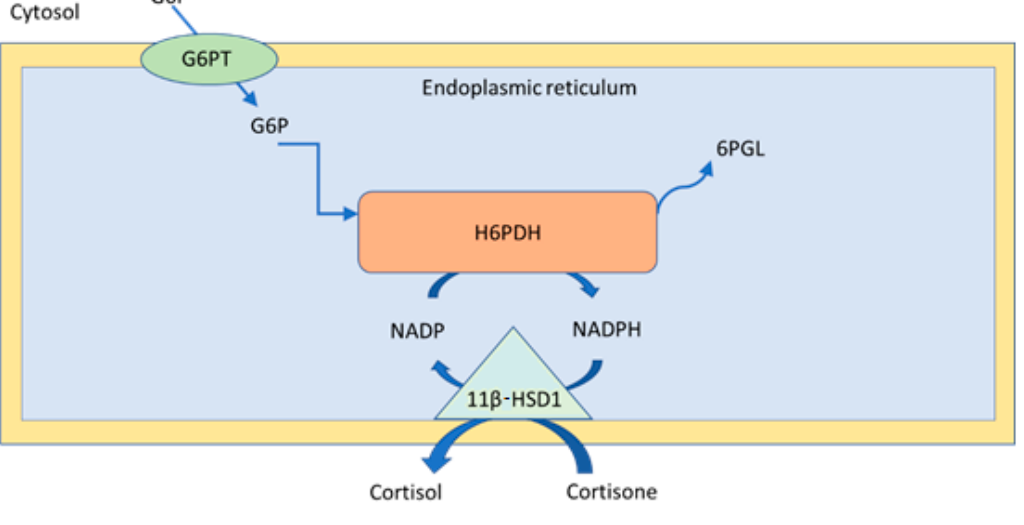
Figure 2. Activity of 11 β -HSD1 in the presence of H6PDH .